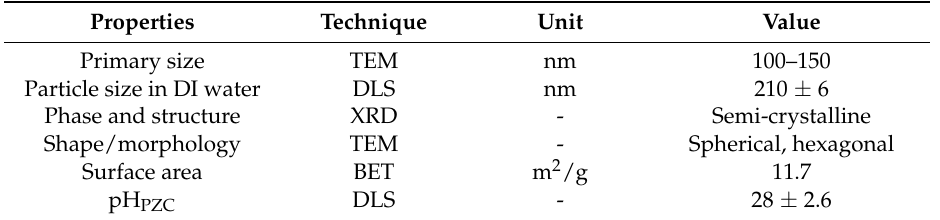
Figure 2. ( A ) SEM image, ( B ) FTIR spectra, and ( C ) X-ray diffraction patterns of ChNPs. ( D ) Impact of ionic strength on the stability of ChNPs, measured as hydrodynamic diameter by dynamic light scattering (DLS). Table 1. Physicochemical characteristics of